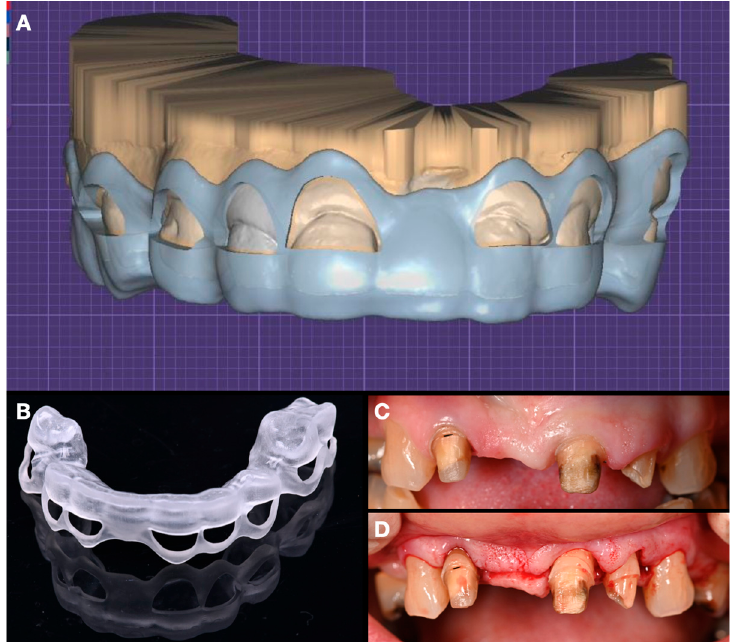
Figure 6. Crown lengthening phase. ( A ) Design of the guide. ( B ) Printed surgical guide. ( C ) Before surgery. ( D ) After surgery.